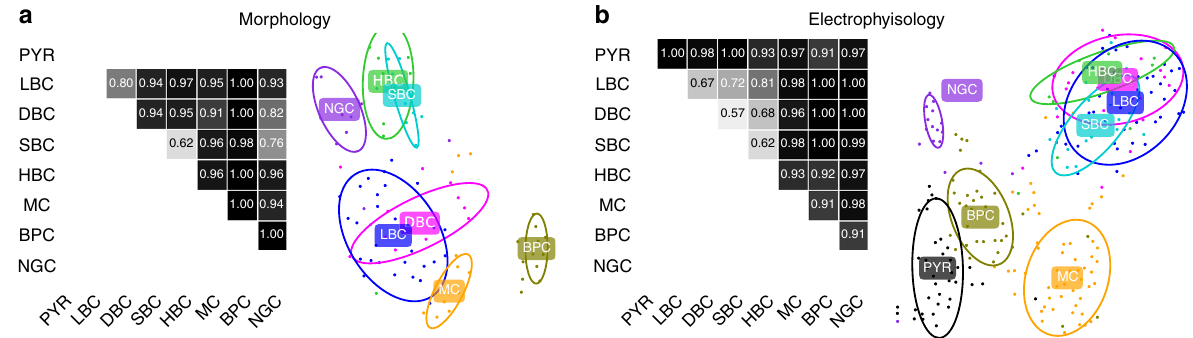
Fig. 2 Discriminability of cell types in V1 L4. a Cross-validated pairwise classi fi cation accuracy for each pair of inhibitory cell types, using regularized logistic regression on a diverse set of morphological features. Total sample size n = 92. Right: 2D visualization of the same n = 92 cells in the space of morphological features using t-SNE. Ellipses show 80% coverage assuming 2D Gaussian distributions and using robust estimates of the mean and the covariance (i.e., ellipses do not include outliers). b Cross-validated pairwise classi fi cation accuracy for each pair of cell types, using electrophysiological features. Total sample size n = 235. Right: 2D visualization of the same n = 235 cells in the space of electrophysiological features using